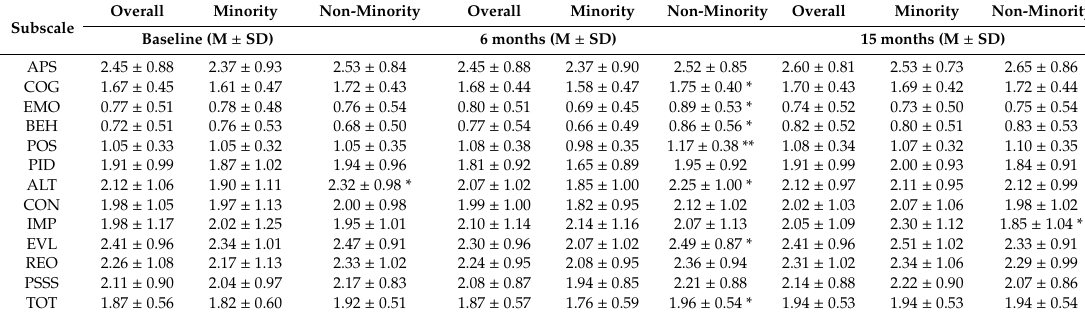
Table 2. Mean Scores for Social Problem-Solving Skills Inventory (SPSI-A): Overall Sample vs. Minority vs. non-Minority Patient